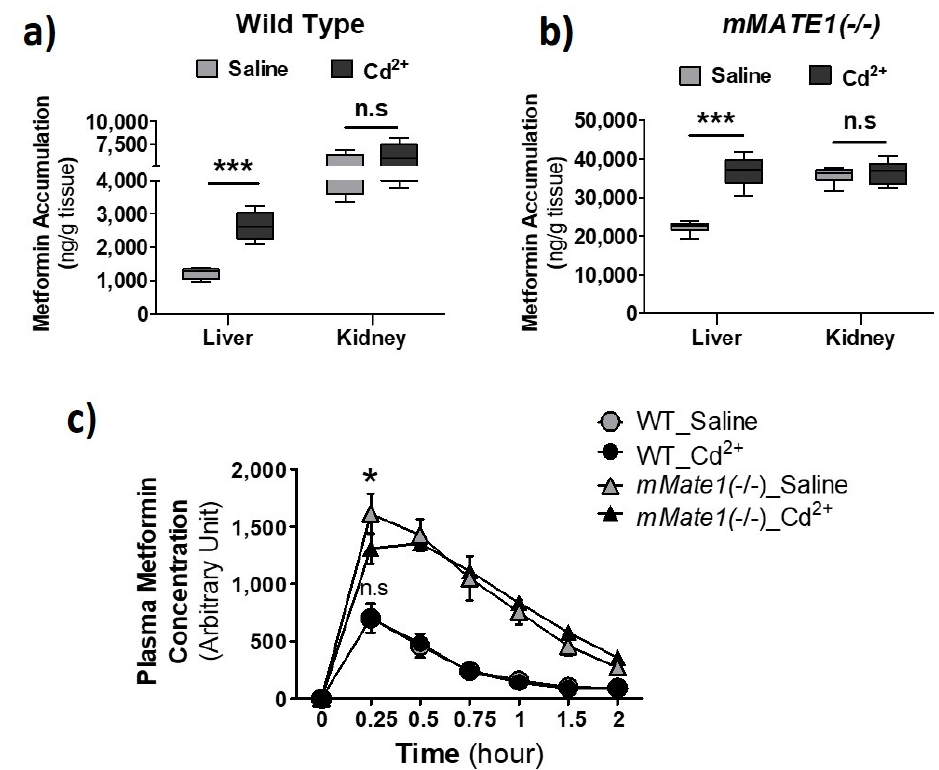
Figure 7. Effect of Cd 2+ exposure on the pharmacokinetics (PK) of metformin in mice. ( a , b ) Accumulation of metformin in liver and kidney after wild-type ( WT ) and mMATE1 knockout( − / − ) mice being treated with and without CdCl 2 (2 mg/kg, i.v.) for 1 h, which was followed by a single dose of metformin (7.5 mg/kg, i.p.). Tissues were collected 30 min after metformin administration. ( c ) Quantification of plasma level of metformin in WT and mMATE1 ( − / − ) mice after being treated with and without CdCl 2 (2 mg/kg, i.v.) for 1 h, which was followed by a single dose of metformin (7.5 mg/kg, i.p.). Blood samples were collected from the tail vein at 0.25, 0.5, 0.75, 1.0, and 2.0 h after metformin administration. For ( a , b ), n = 4; for c, n = 3 or 4. Data are presented as mean ± S.E.M.; * p < 0.05, *** p < 0.001; n.s., no significance.